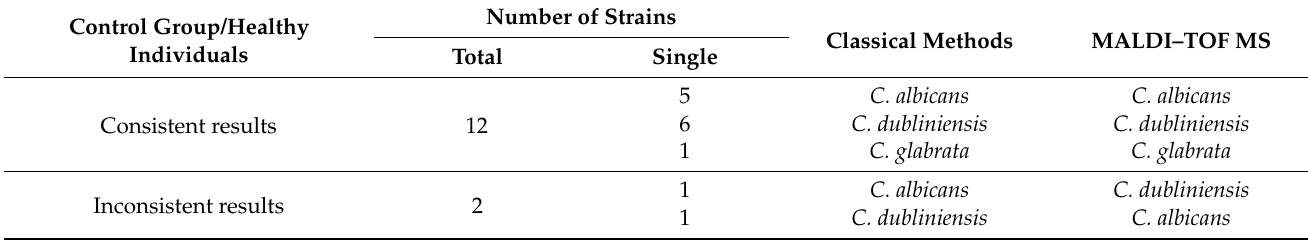
Table 2. Comparison of results of fungi identification in the control group (healthy people, not infected with HIV).